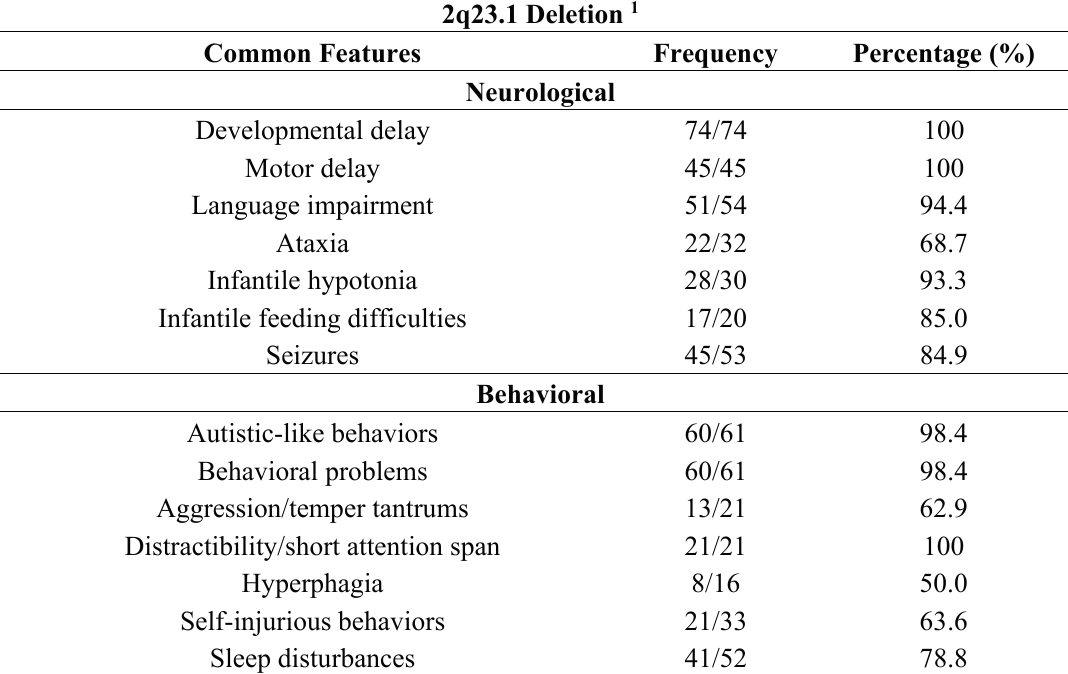
Table 1. Prevalent features of 2q23.1 deletion